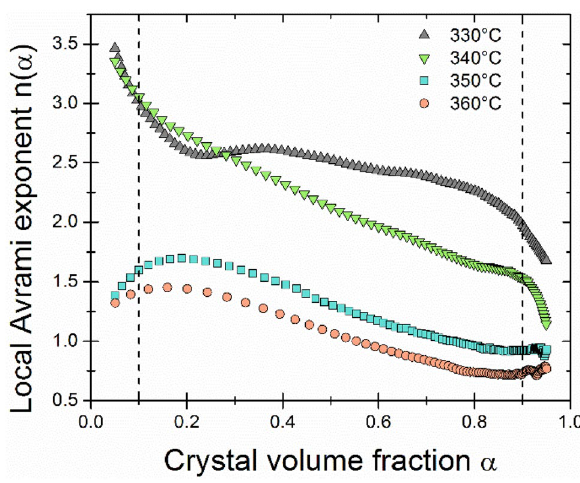
Figure 2. Local Avrami exponents in the function of the crystallized